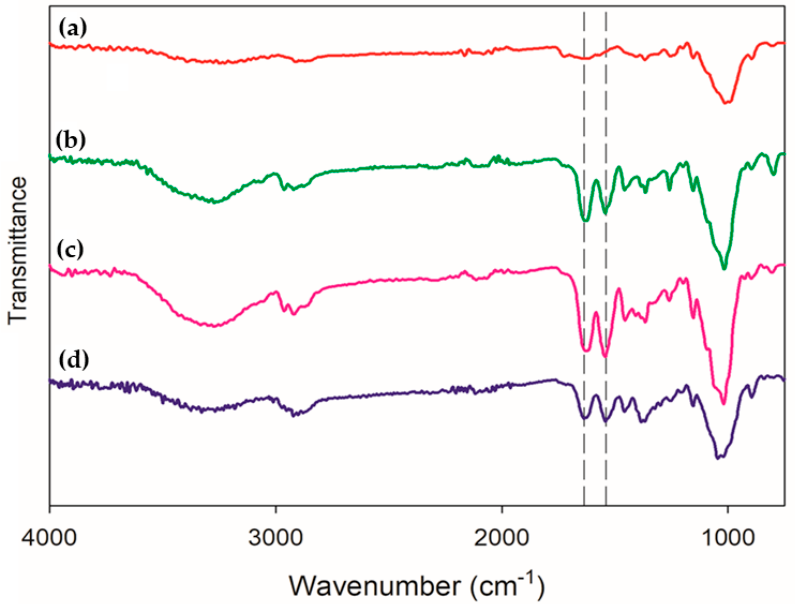
Figure 11. FTIR spectra of different cellulose films (a) MCC film, (b) cellulose(L)- g -PNIPAAm-Br, (c) cellulose(H)- g -PNIPAAm-Br, and (d) 50 wt% cellulose(H)- g -PNIPAAm-Br + 50 wt% cellulose pulp.